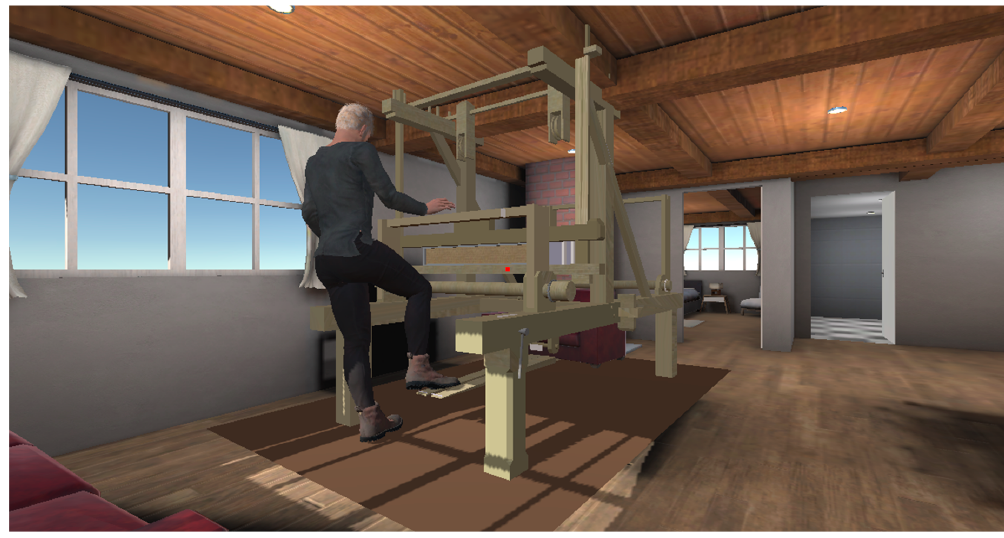
Figure 14. Weaving VR example.